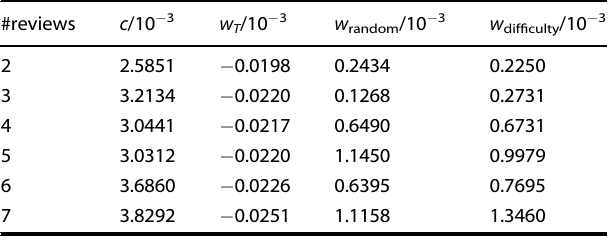
Table 1. Multiple regression analysis to study the dependence the normalized empirical forgetting rate on the group assignment and the review time (Lower is